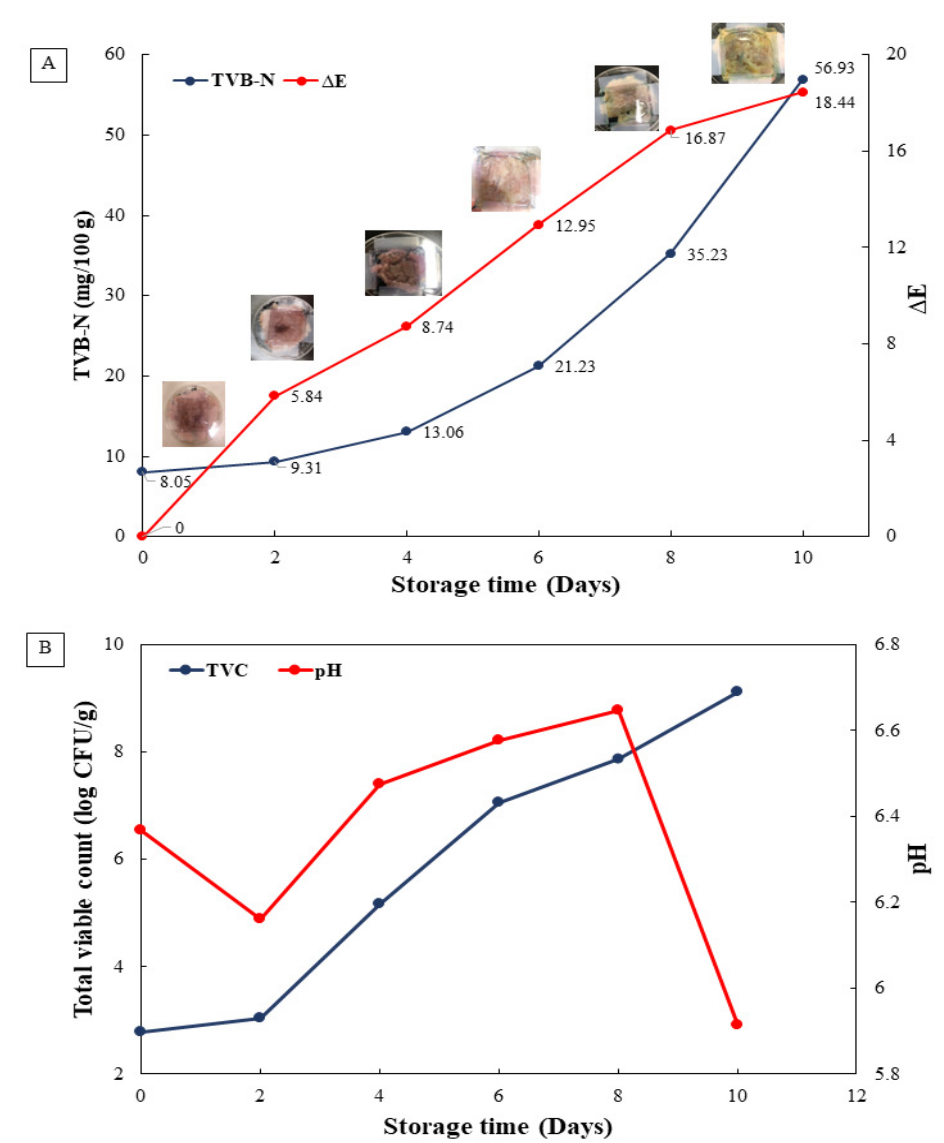
Figure 6. TVB-N content, color difference (del E) ( A ) and total viable count, pH ( B ) of the fish samples using intelligent multi-layer film for 10 days of storage at 4 °C.